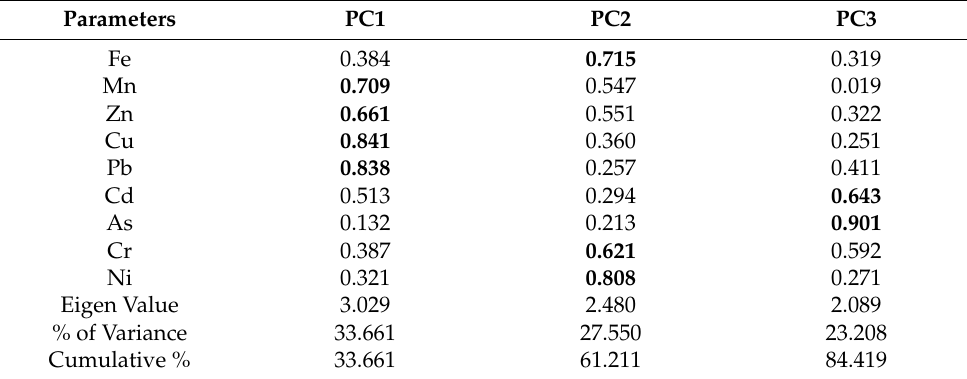
Table 7. PCA loadings of variables of significant principal